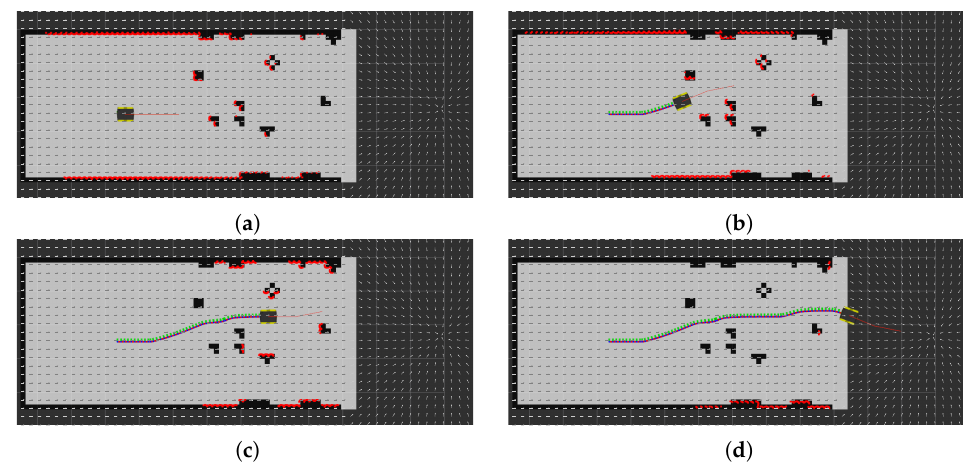
Figure 10. From ( a – d ), four snapshots of the solution provided by SSLAT in environment #6 of the BARN dataset (see Figure 9). The planned path is shown in red. The executed path is shown by a sequence of reference coordinate frames. A close inspection shows that the path of the robot follows the vector field whenever there are no interfering obstacles. Notice that the occupancy grid of the environment is shown for just to illustrate the scenario, and it is not used by